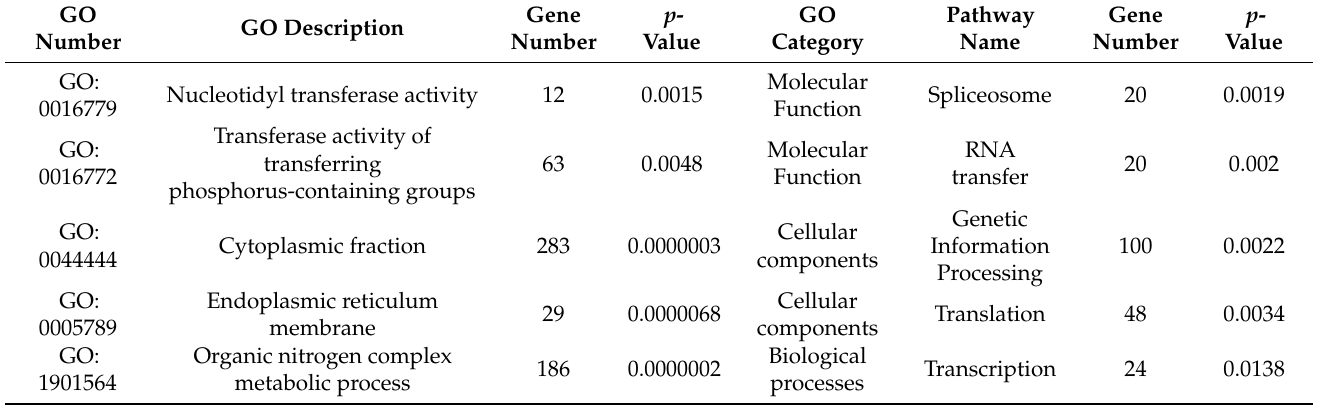
Table 5. CK versus NaCl comparator group-specific differential alternative splicing genes significantly enriched in GO entries and KEGG